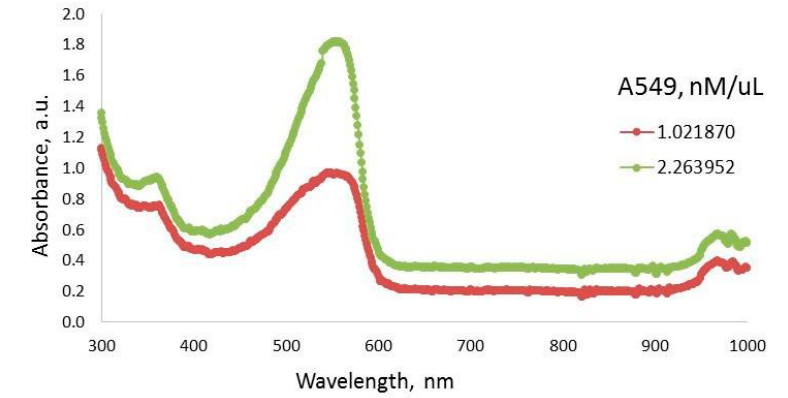
Figure 3. Optical measurement performed with UV-Vis Spectrophotometer: Absorbance of A549 cells solutions change with their concentration.